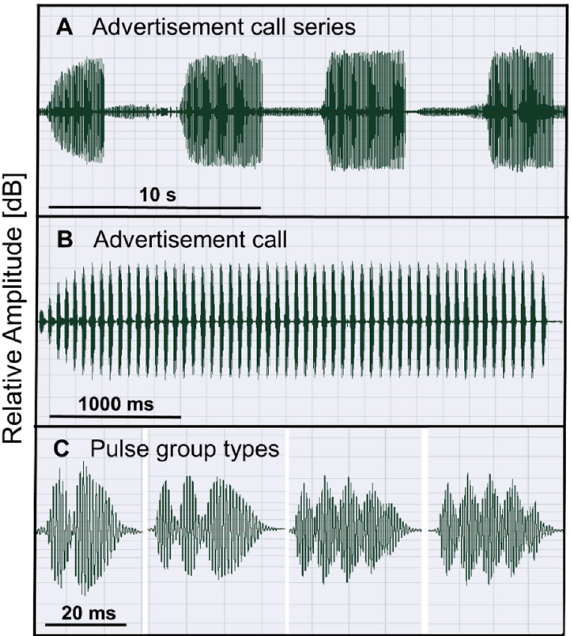
Figure 1. Oscillograms of the advertisement call of R. arenarum . ( A ) Series of four consecutive calls. ( B ) Single call consisting of 56 pulse groups, each formed by 2 to 5 pulses. ( C ) Close-up of the pulse group types. Bars indicate temporal resolution. The call series was recorded at 20.9 °C.